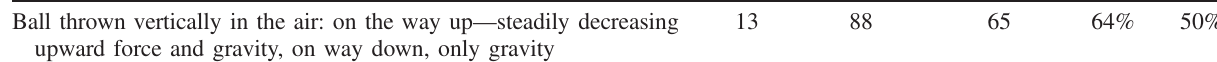
upward force and gravity, on way down, only gravity Question 13. Ball thrown vertically in the air, no air resistance. Find the forces acting on the ball while in the